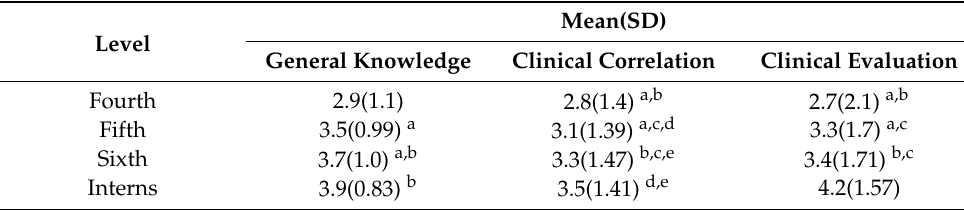
Table 3. Average score for each section in relation to academic year with results of Tukey’s post hoc